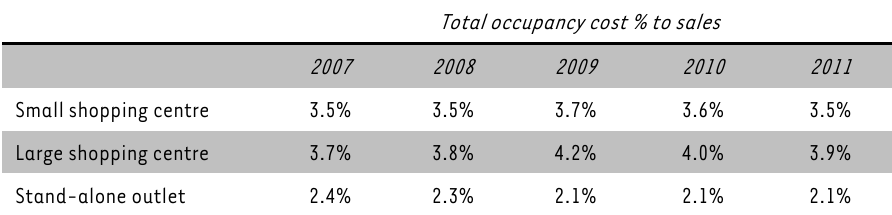
TABLE 6: Total occupancy costs percentage to sales by retail format